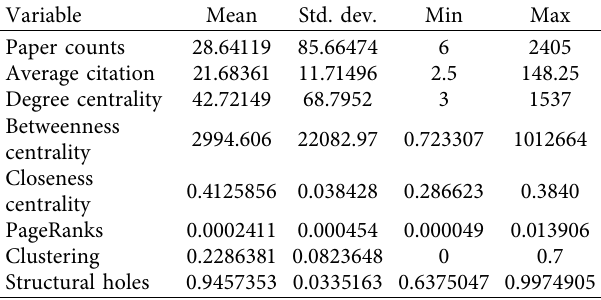
Table 2: Descriptive statistics of